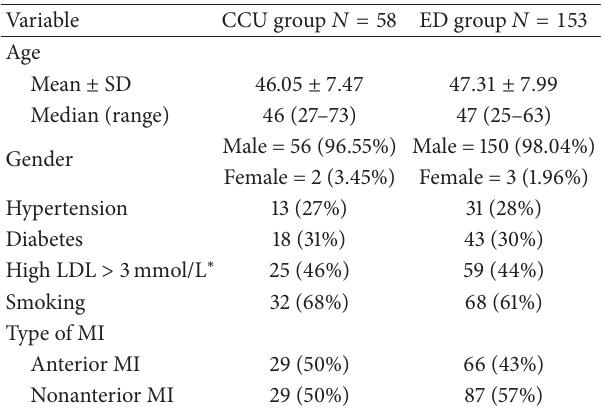
Table 1: Demographic and clinical data in patients with acute